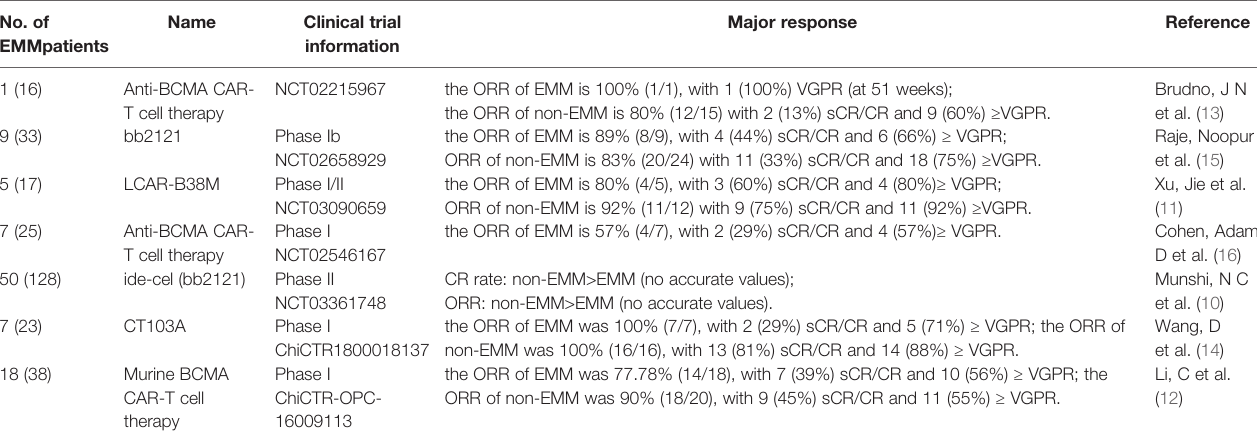
TABLE 1 | Anti-BCMA CAR-T cell products in clinical trials included EMM